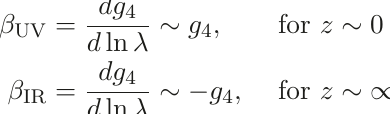
4 . But on the either side of = 0) are well 6